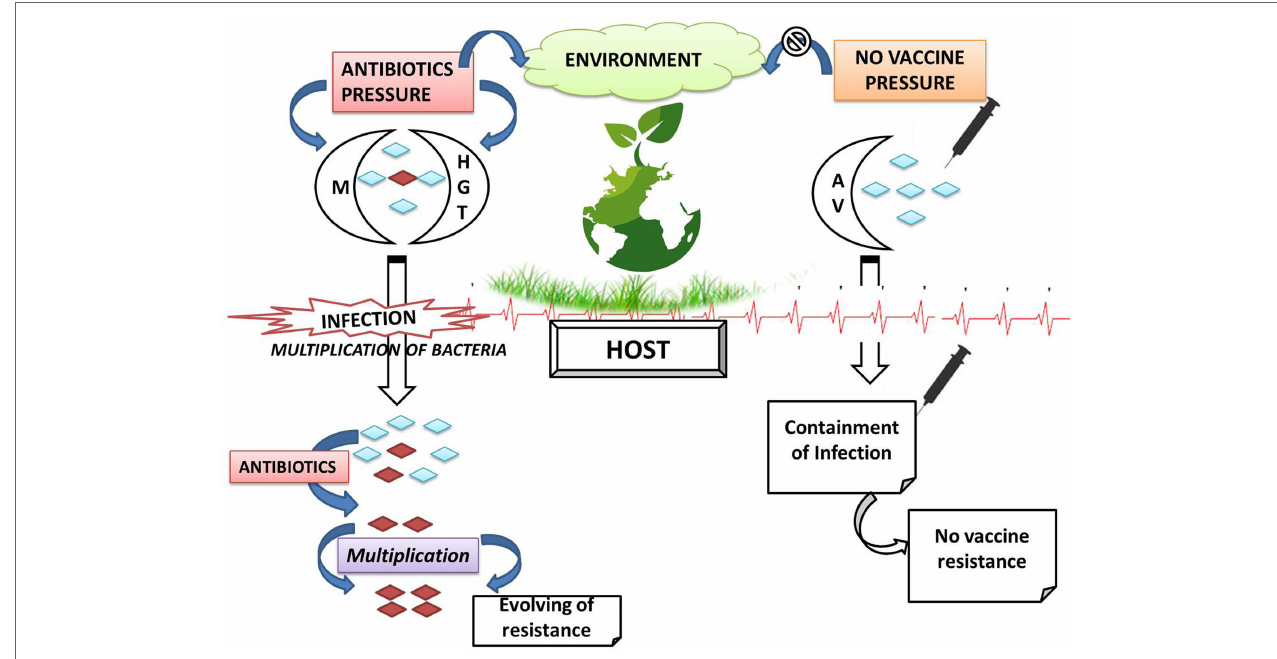
FiGURe 5 | Comparative resistant phenomenon with respect to antibiotics and vaccines (M, mutation; HGT, horizontal gene transfer; AV, antigenic variation; , antibiotic-resistant bacteria; antibiotic-sensitive